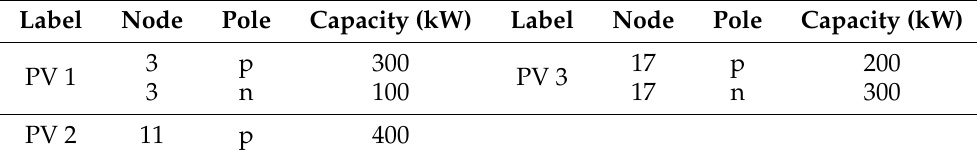
Figure 2. Available power curve of the three PV generators and demand variation. Table 3. Location and capacity of the PV